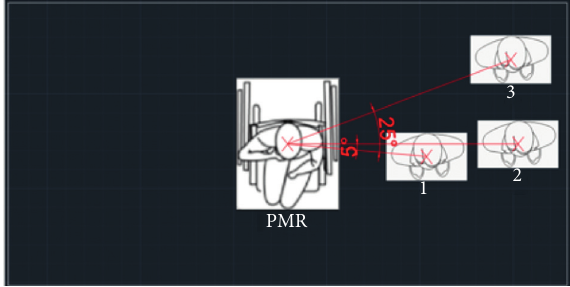
Figure 5: Marking of users outside the